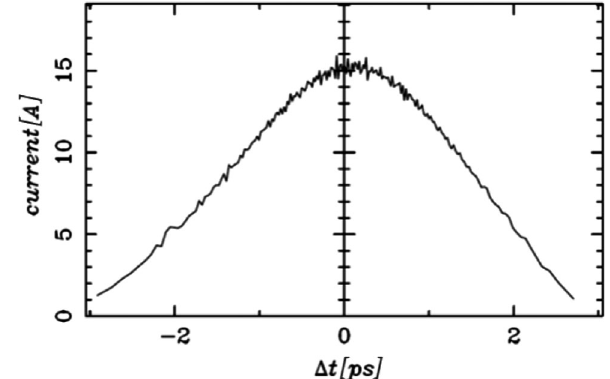
FIG. 8. Bunch current profile at the BAC entrance. It is worth to note the symmetric distribution and the low slope ramps, which mitigate CSR emission negative effects.